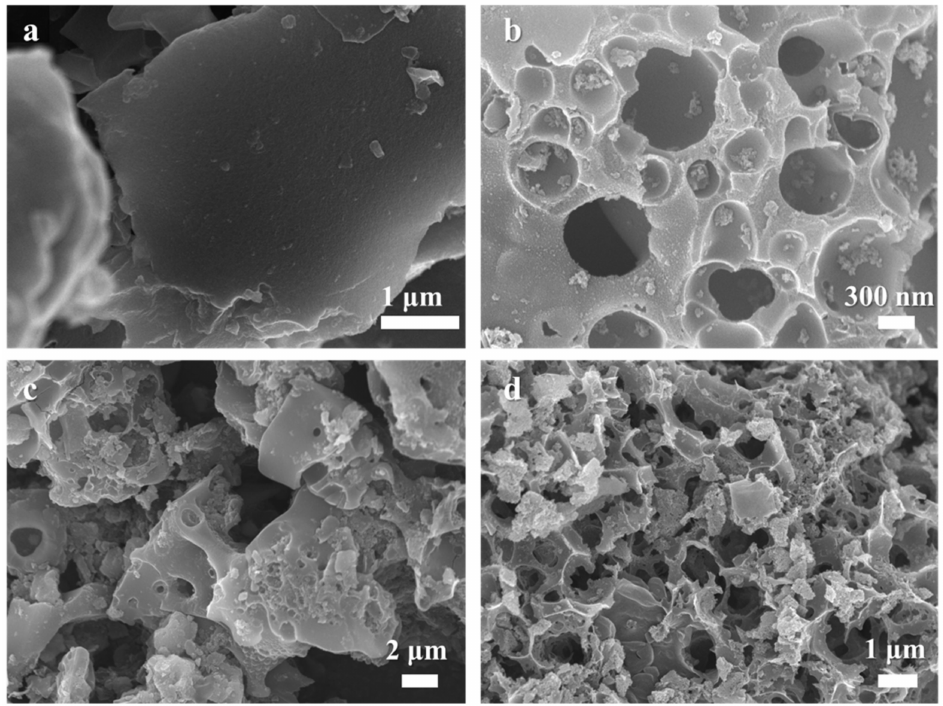
Figure 1. Scanning electron microscope (SEM) images of ( a ) GTPC-0, ( b ) GTPC-1, ( c ) GTPC-2, and